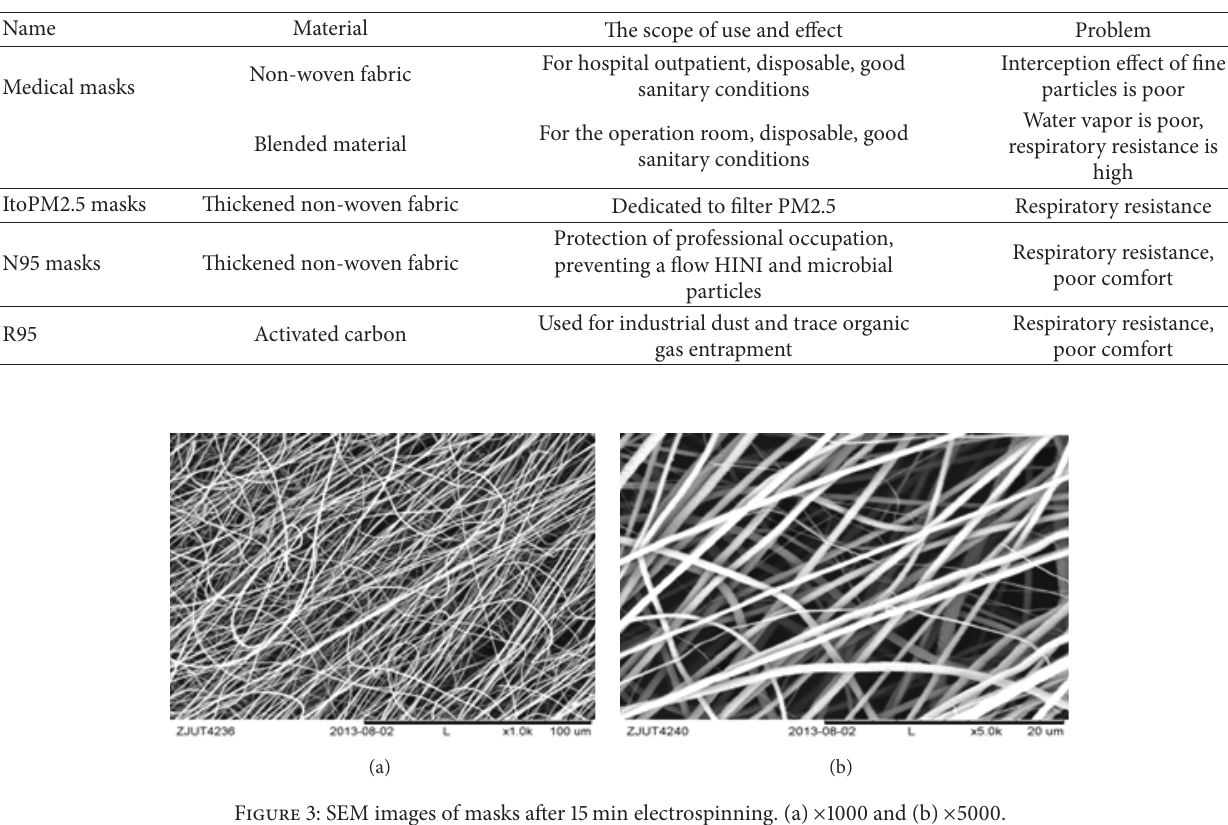
Table 4: Comparison of different masks.